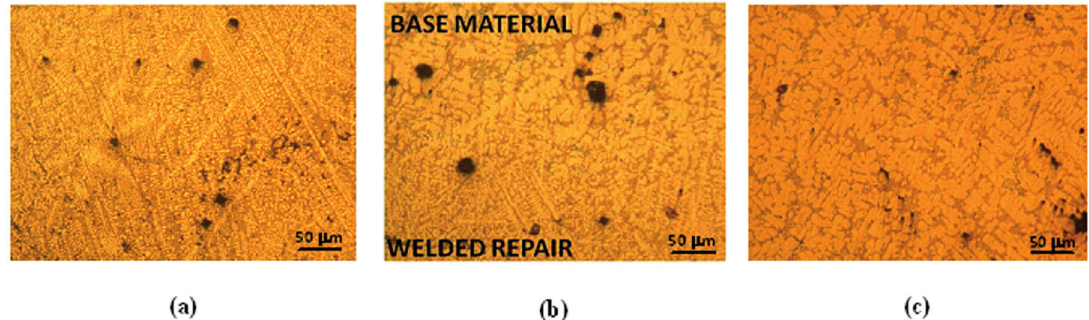
Figure 8: (a) Microstructure observed in the cross section of the welded repair; (b) microstructure of the welded repair near to the base material; (c) micrograph of the base material near to the repair.